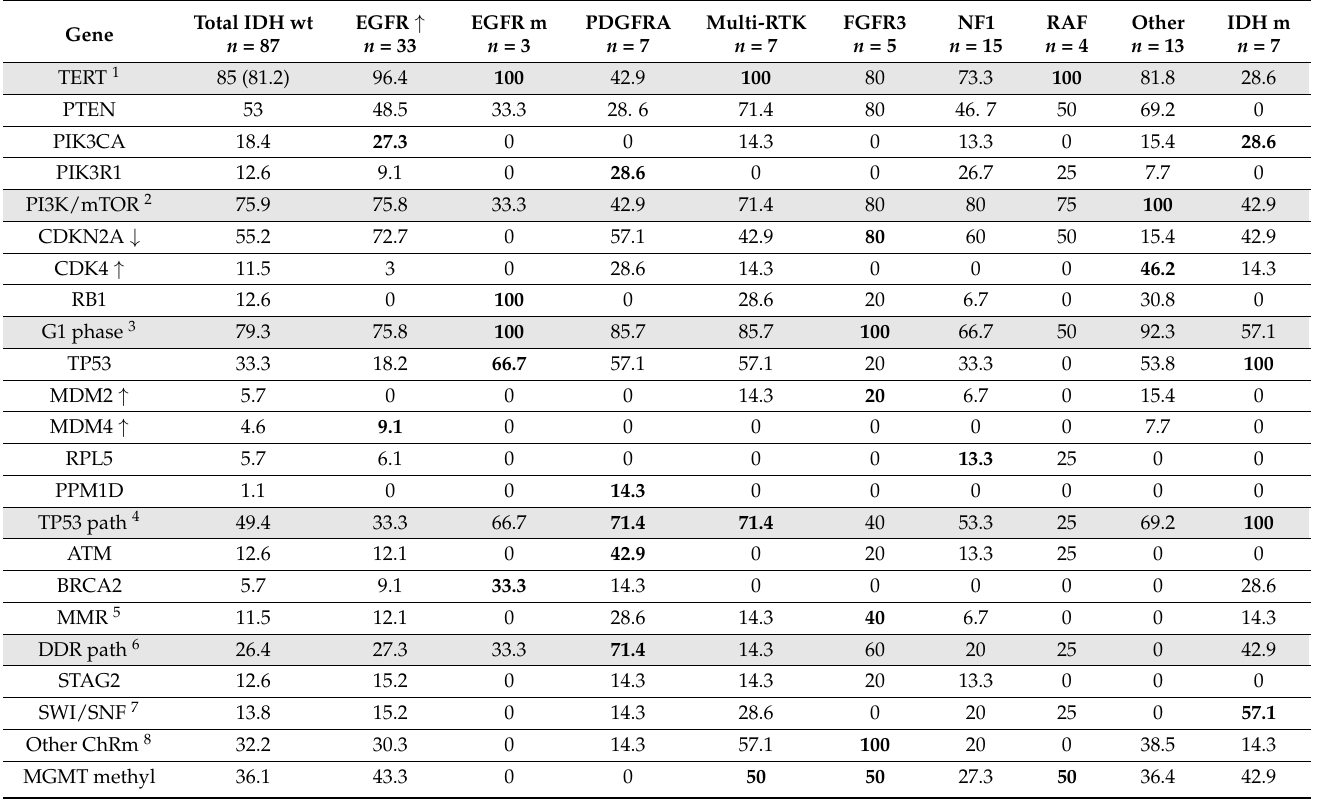
Table 1. Mutation percent (%) frequency in glioblastoma